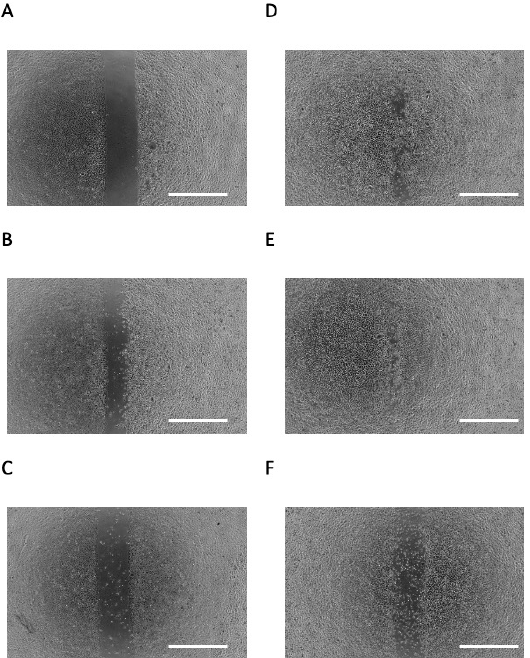
Figure 2. Effects of butyric acid (BA) on cell migration. Photomicrographs of scratch assay at day 0 ( A ), incubated with several concentrations of sodium butyrate (NaB), 0 mM ( B ), 0.02 mM ( C ), 0.2 mM ( D ), 2 mM ( E ) and 20 mM ( F ), for 1 day. All photomicrographs showed typical example of six independent experiments. Scale bar = 1 mm.